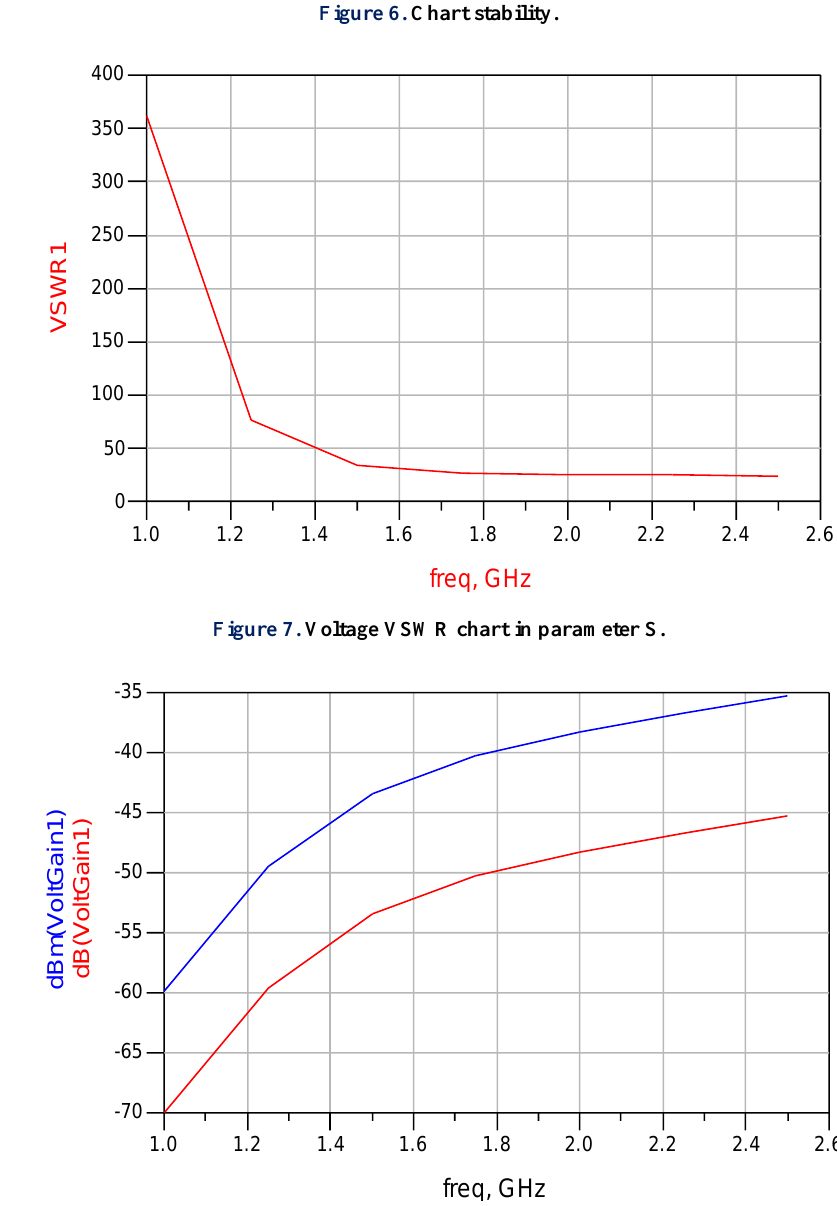
Figure 8. Voltage